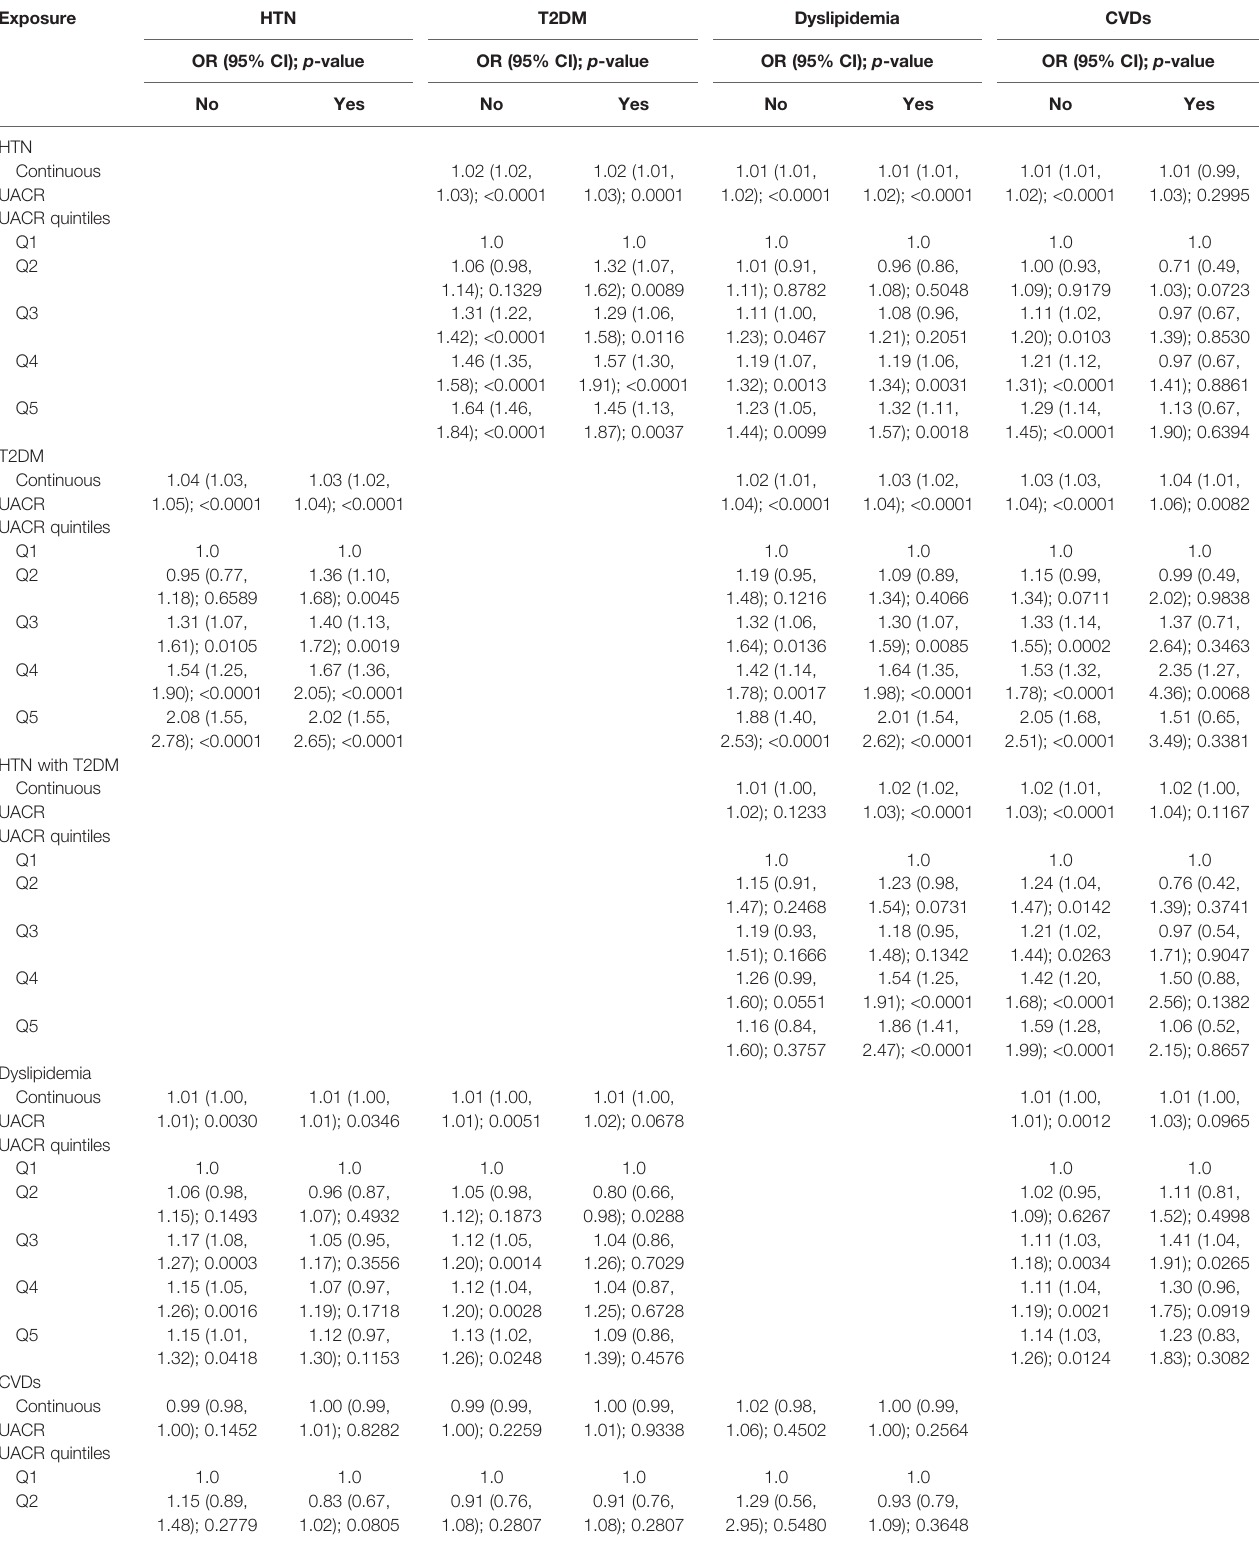
TABLE 4 | Strati fi ed analysis of associations between UACR and HTN, T2DM, HTN with T2DM, dyslipidemia, and CVDs in participants with normal UACR (<30 mg/g) in model 3.